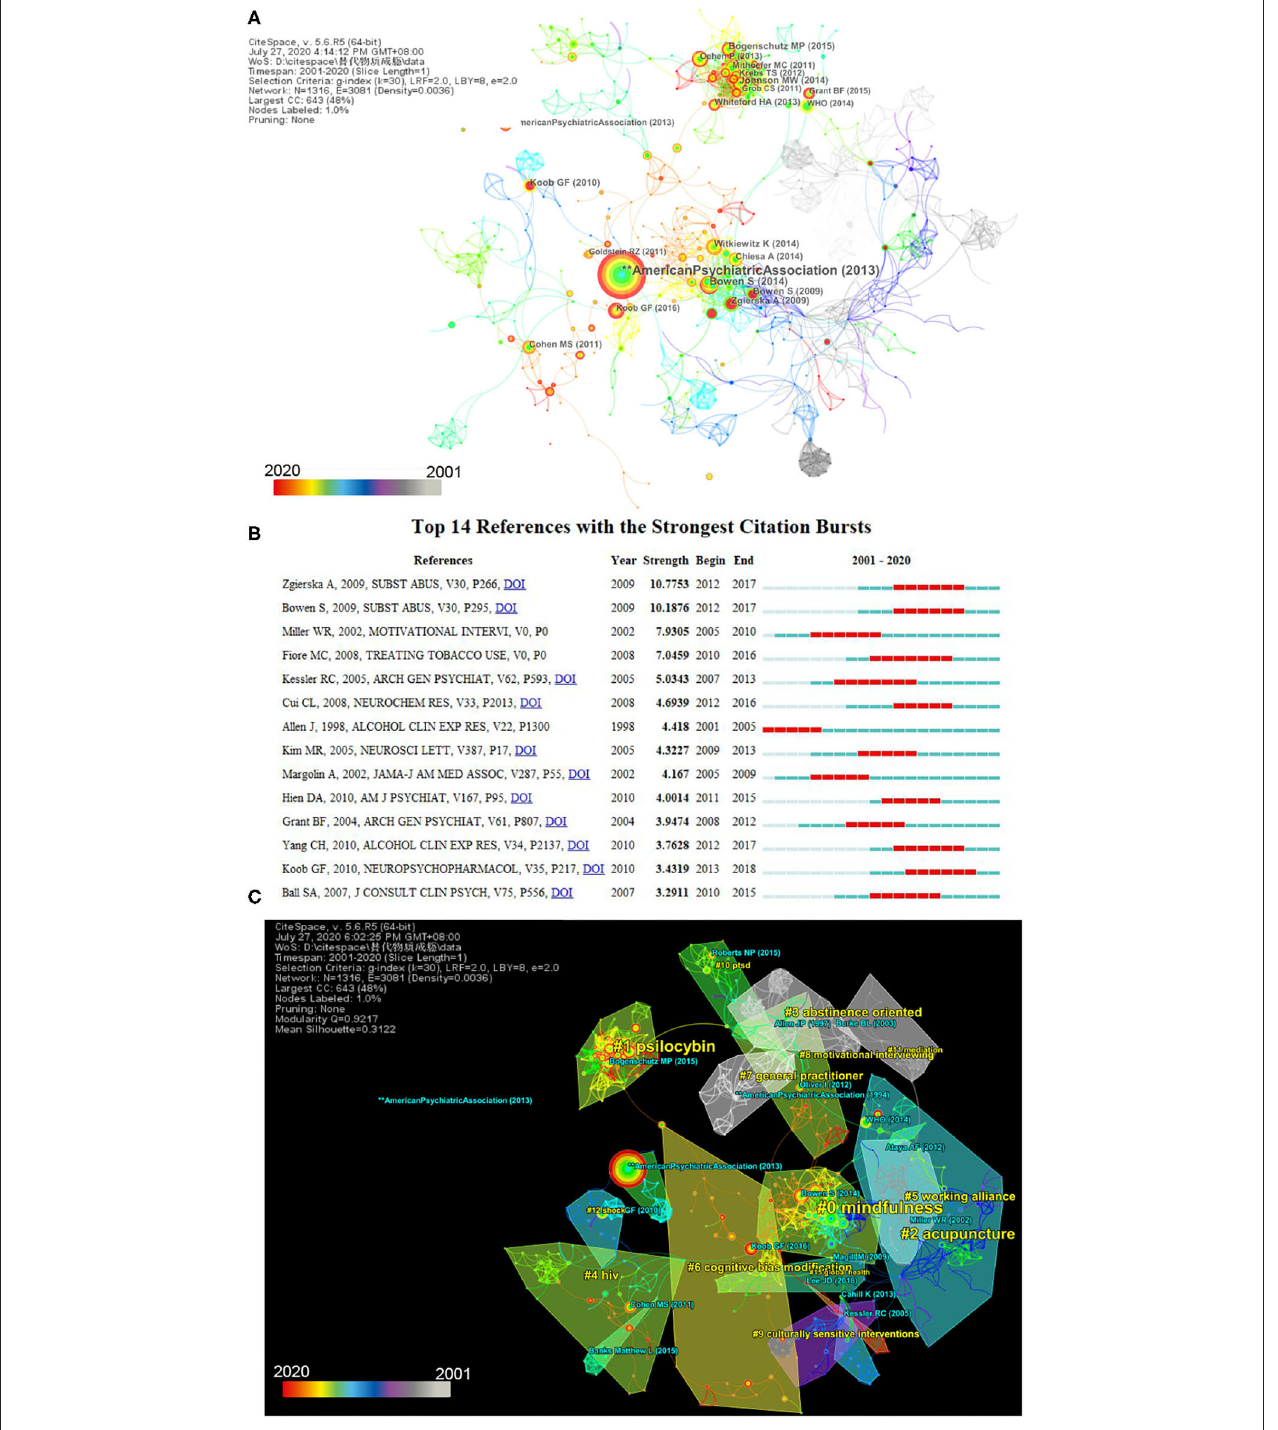
FIGURE 7 | Visualization of references for complementary and alternative medicine (CAM) for substance use disorders (SUDs). (A) The network map of cited references for CAM for SUDs (top 15 results). A total of 1,316 references were cited, with 1,316 nodes and 3,081 links. (B) The co-occurrence network map of the cluster of references. The modularity Q was 0.9217, and the mean silhouette was 0.3122. (C) Top 14 references with the strongest citation bursts. Each bar presents each year from 2001 to 2020. The red bar indicates that the institution had frequent citation bursts, and the blue bar indicates that the institution had infrequent citation bursts. Time slice on 1 year, and different colors present different years as the legend shows. The nodes consist of an annual ring by different colors as the legend, and the thickness of the annual ring represents times of cited study at the corresponding time. The area with similar color suggests similar clusters and shows cluster at the corresponding time as